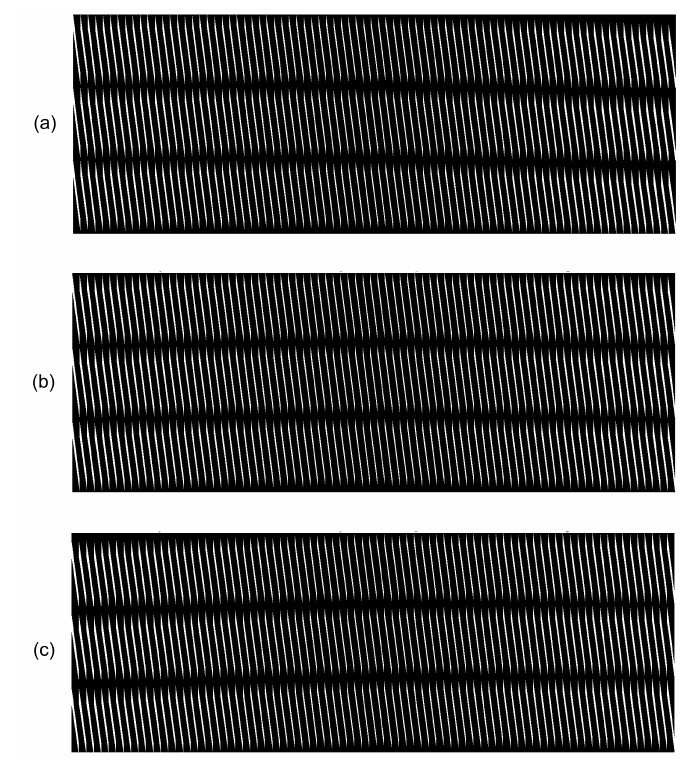
Figure 1. Depiction of the model matrix H . ( a ) On top, three stripes rows represent the sub-matrices H 1 to H 3 ; ( b ) In the middle, the sub-matrices H 31 to H 33 ; ( c ) In the bottom, the sub-matrices H 62 to H 64